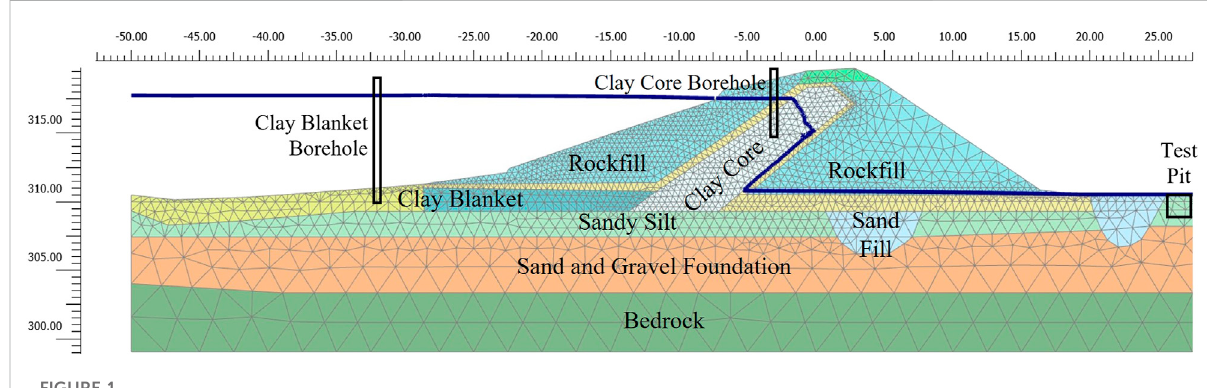
FIGURE 1 CB block dam cross section with approximate sampling borehole and test pit